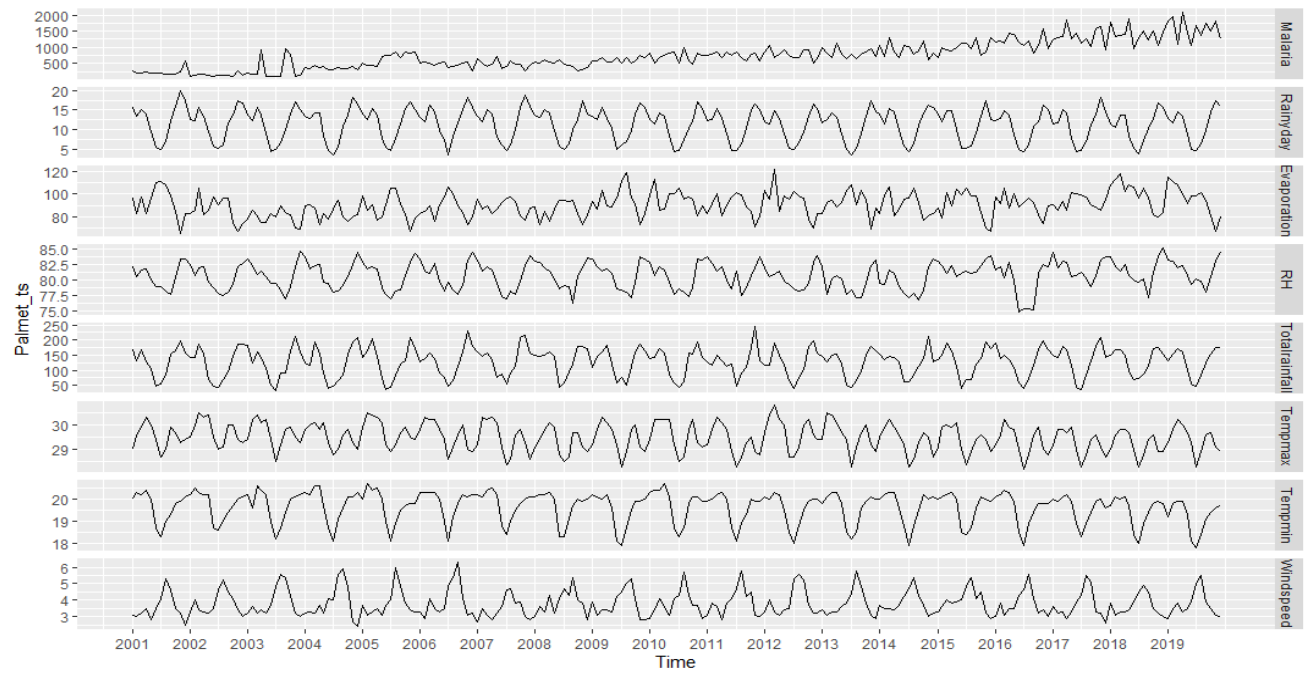
Figure 7. Evolution of study variables from 2001 to 2019. The legends of the variables are shown in the Appendices A and B. Note: The number of malaria cases is obtained by multiplying the absolute number on the y axis by 10³.